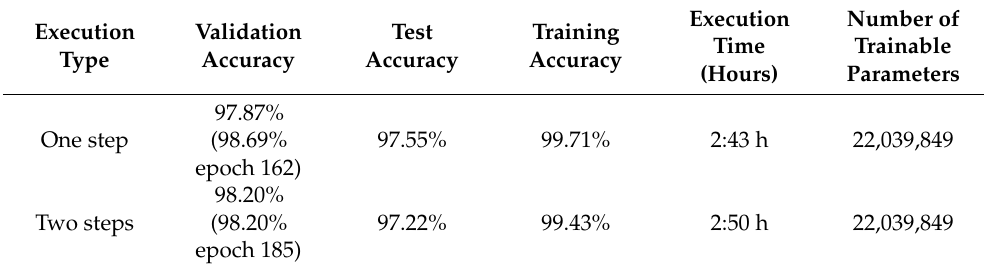
Figure 7. Transfer Learning concept with our recommended one-step variant in red text. Table 1. Differences in accuracy and execution time with one-step and two-step approaches for fine-tuning. InceptionV3 architecture, 200 epochs and 8 trainable base layers for fine-tuning in the two-step approach.